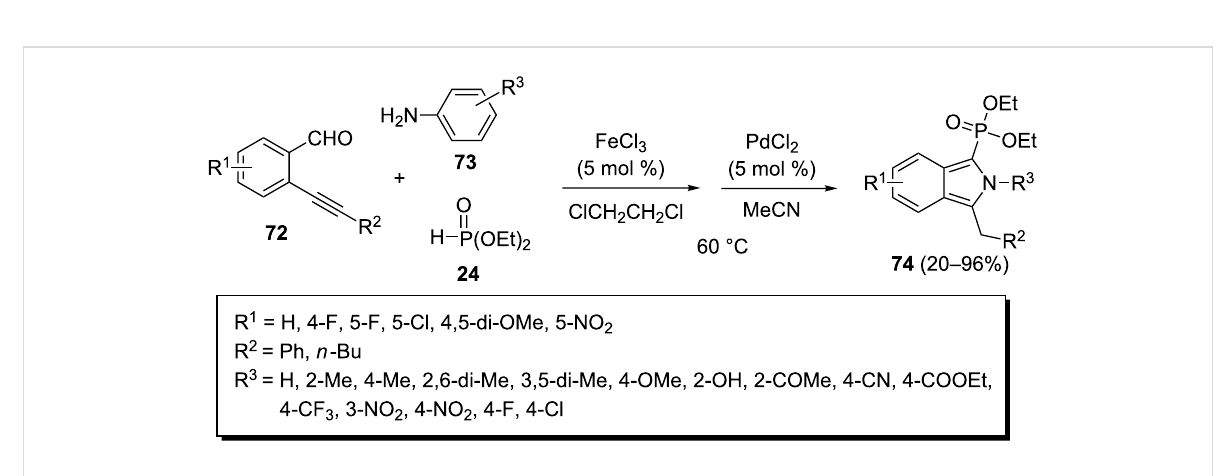
Scheme 17: An efficient one-pot method for the synthesis of ethyl (2-alkyl- and 2-aryl-3-oxoisoindolin-1-yl)phosphonates.